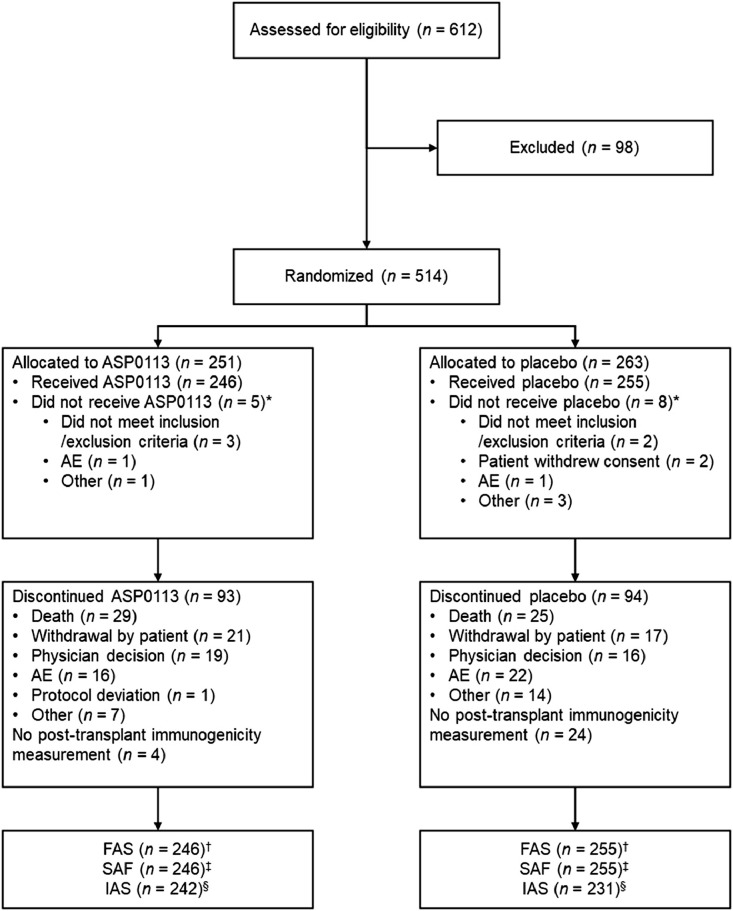
Trial profile *Randomisation was blinded, so allocation to treatment group could not influence the likelihood of receiving treatment. †The FAS consisted of all randomised patients who received at least one dose of randomly assigned study drug. ‡The SAF consisted of all randomised patients who received at least one dose of study drug. §The IAS included all patients who received at least one dose of study drug and for whom at least one post-transplant immunogenicity measurement was available. AE=adverse event; FAS=full analysis set; IAS=immunogenicity analysis set; SAF=safety analysis set.